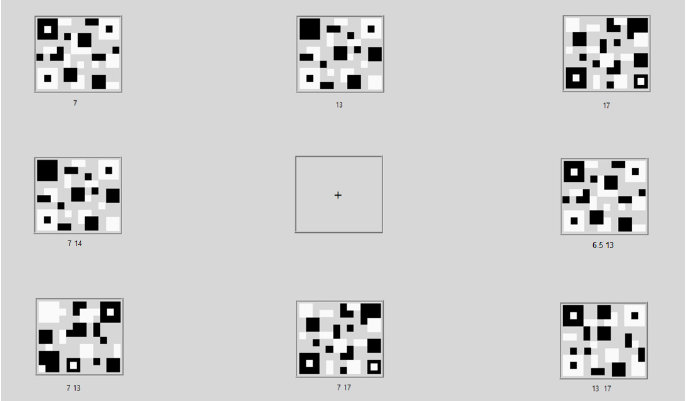
Figure 4. Screenshot the proposed visual stimuli, using a QR code pattern with three fundamental flickering frequencies and harmonics for eight different flicker patterns (Table 2), through an LCD monitor for SSVEP stimulation.